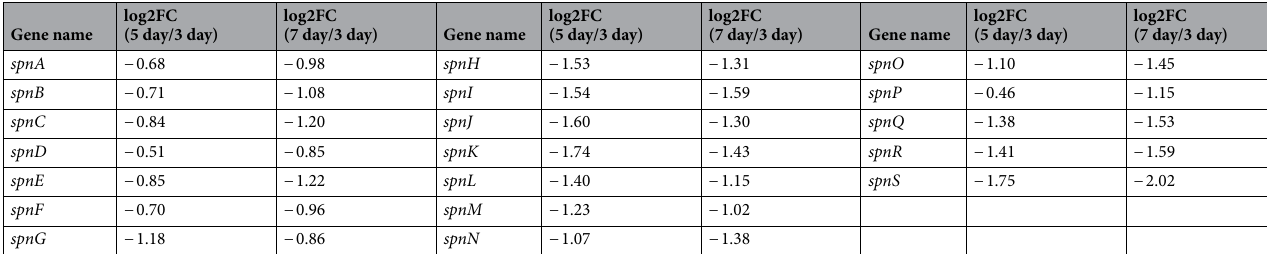
Table 3. The expression differences of genes located in spinosad biosynthetic gene cluster between different time points in S. spinosa S3-3.